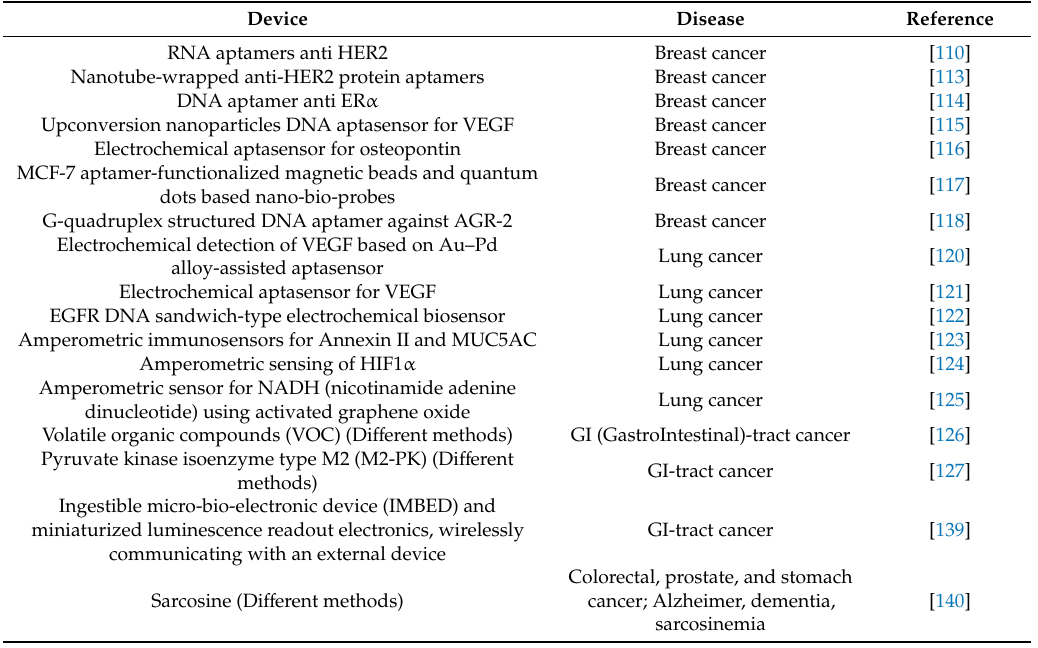
Table 1. Clinical application in oncology.